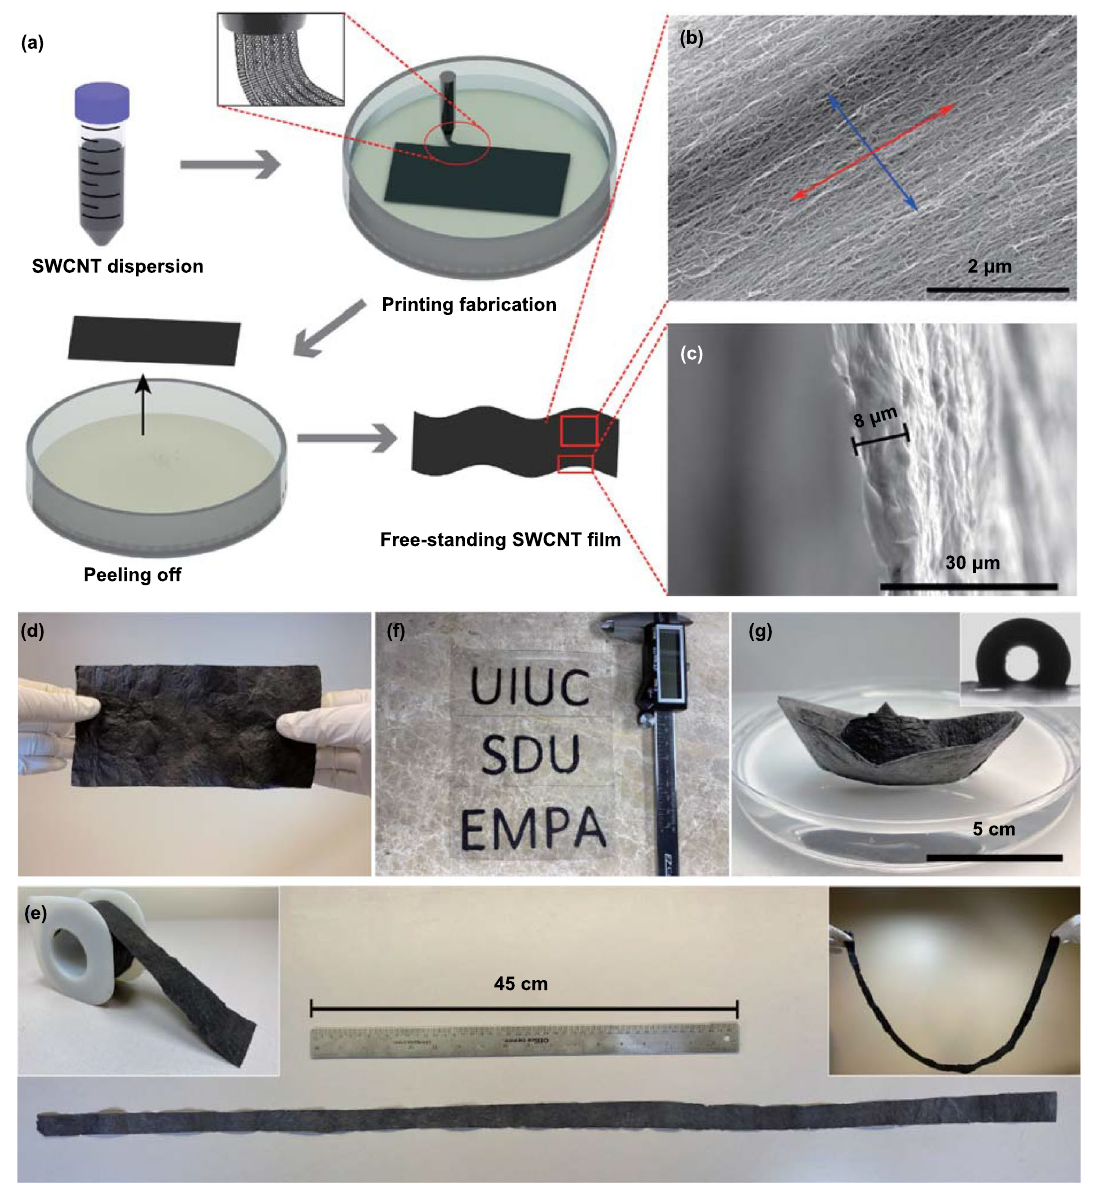
Fig. 1 a Schematic for printing fabrication process of freestanding SWCNT film. b In-plane SEM image of the SWCNTs, showing the aligned SWCNTs in print (red arrow) direction. c Side-view SEM image of the SWCNT film, showing a typical thickness of 8 µm. d Photograph of a large-area (10 × 20 cm 2 ) freestanding SWCNT film held by hands. e Demonstration of a meter-long freestanding SWCNT film. f Printed letters of SWCNTs on PET. g Origami boat made from SWCNT film floating on water (inset shows the water contact angle of 125° for the